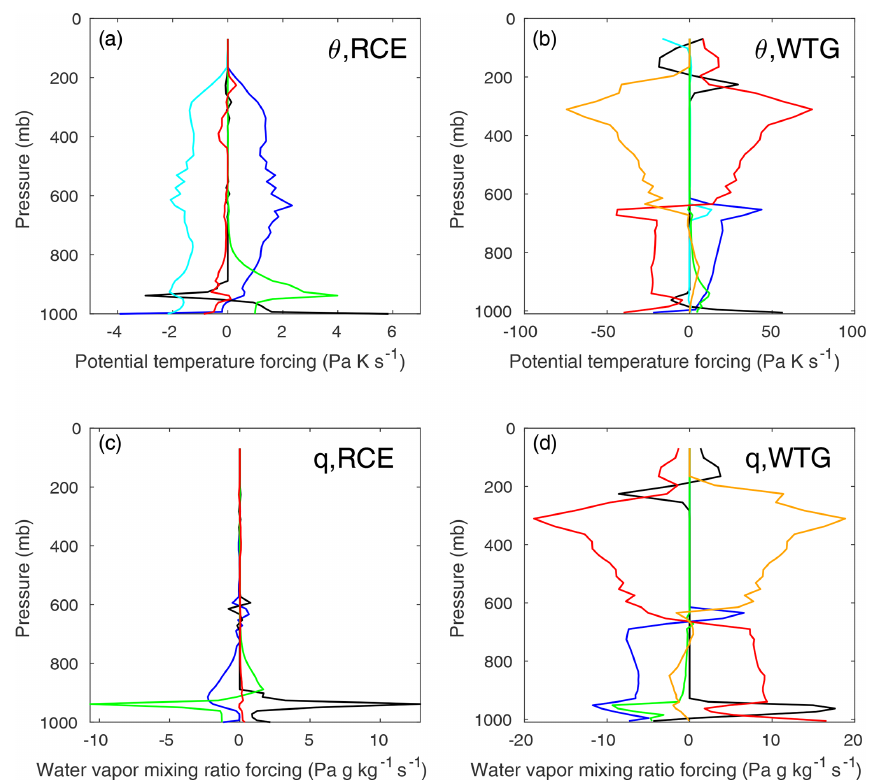
Figure 2. (a, b) Column profiles of the potential temperature ( θ ) forcings from Eq. (1) averaged over the last 30d of RCE (a) and WTG (b) ex- periments, both run for 180d with fixed SST of 300K. The forcings are from the deep-convective (blue), shallow-convective (green), bound- ary layer (black), radiative (cyan), and microphysics (red) CAM parameterizations and the WTG relaxation scheme (orange). (c, d) Column profiles of the water vapor mixing ratio ( q ) forcings for the same two experiments. The WTG background profile was calibrated to an SST of